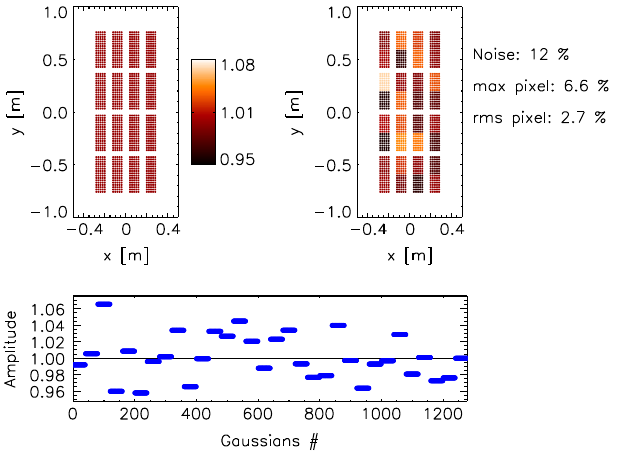
FIG. 10. Phantom 12 (top left) and its tomographic reconstruc- tion (top right) using the 32 pixel configuration with noisy data. The rms of the ratio noise/signal is 12%.